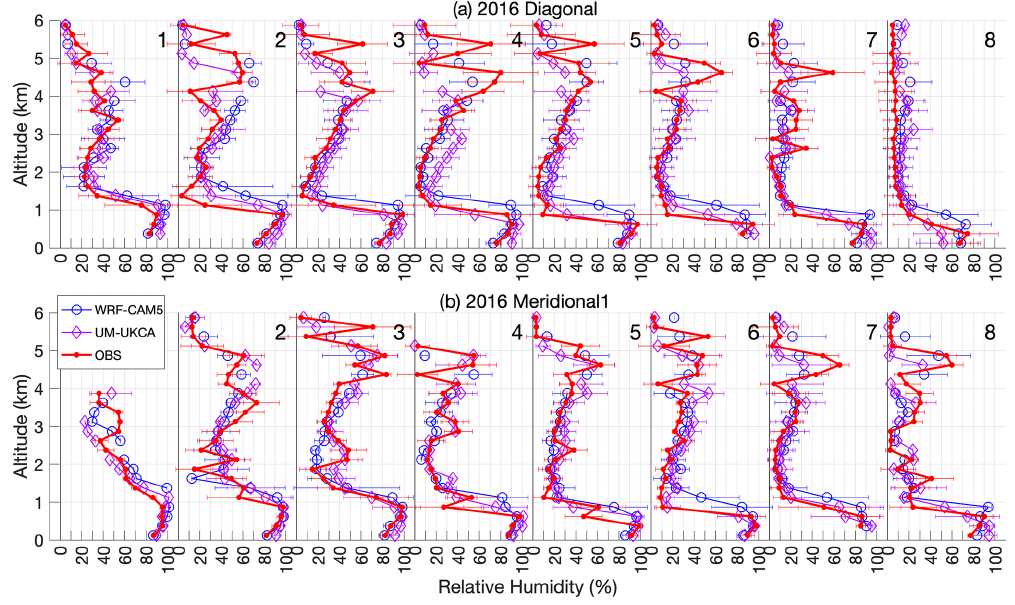
Figure 10. As in Fig. 6 but for RH and at 250m vertical resolution rather than 500m vertical resolution.